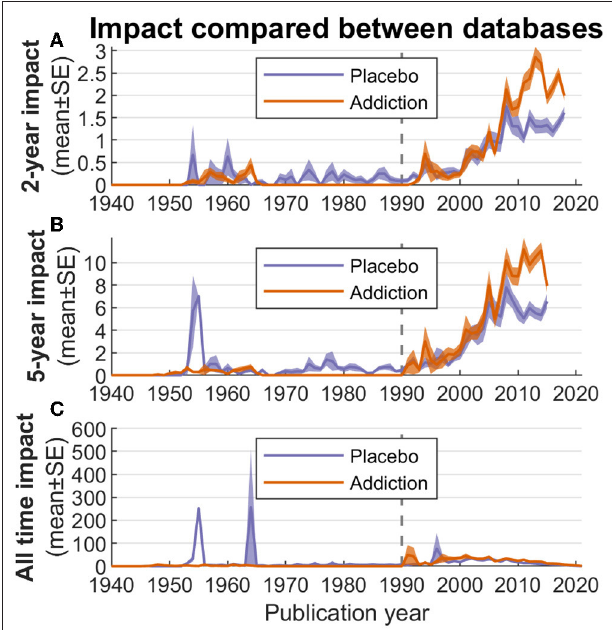
FIGURE 8 | Average impact of all articles per year in the JIPS database and comparator database. (A) 2-year impact. (B) 5-year impact. (C) All-time impact. The gray vertical line marks the introduction of the “placebo effect” MeSH term (1990), coinciding closely with introduction of the “behavior, addictive” MeSH term (1992).